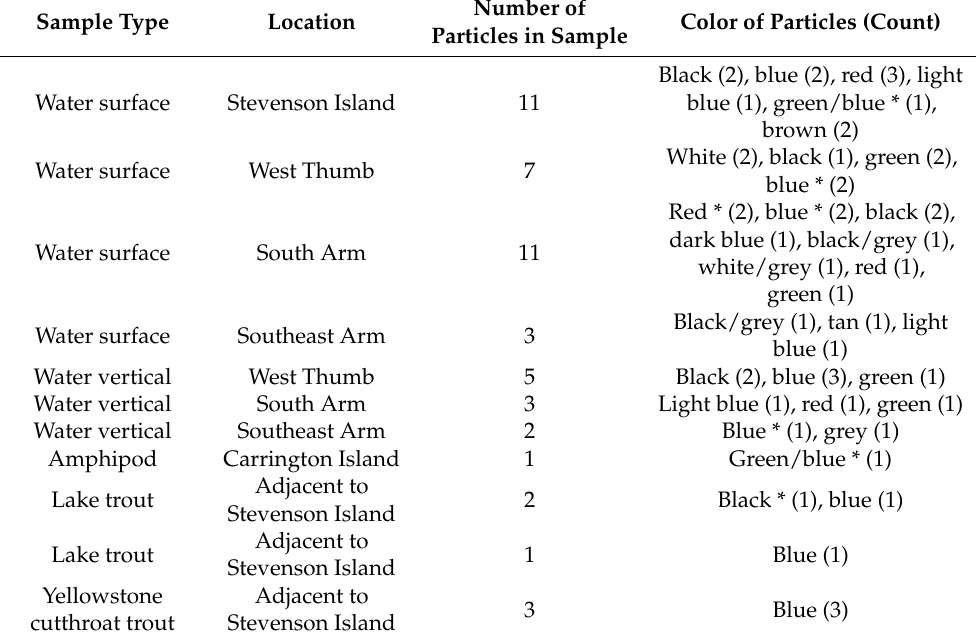
Table 2. Color and number of particles sampled by sample type and location collected during 2019 in Yellowstone Lake, Yellowstone National Park, Wyoming, USA. Colors with an asterisk (*) denote the microplastic was sent for Fourier-transform infrared (FTIR) or Raman spectroscopy identification.